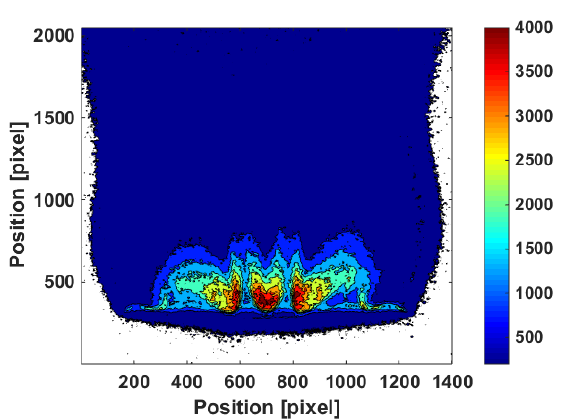
Fig. 15. Image gradient depending on CCD exposure time for